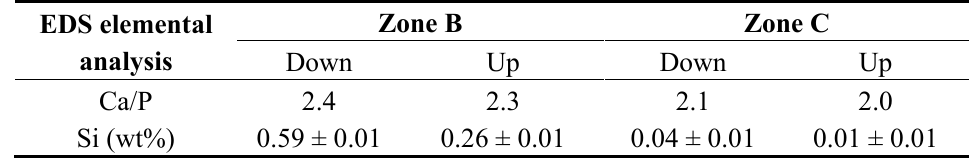
Table 1. EDS elemental analysis of the implant-bone interface after four months of